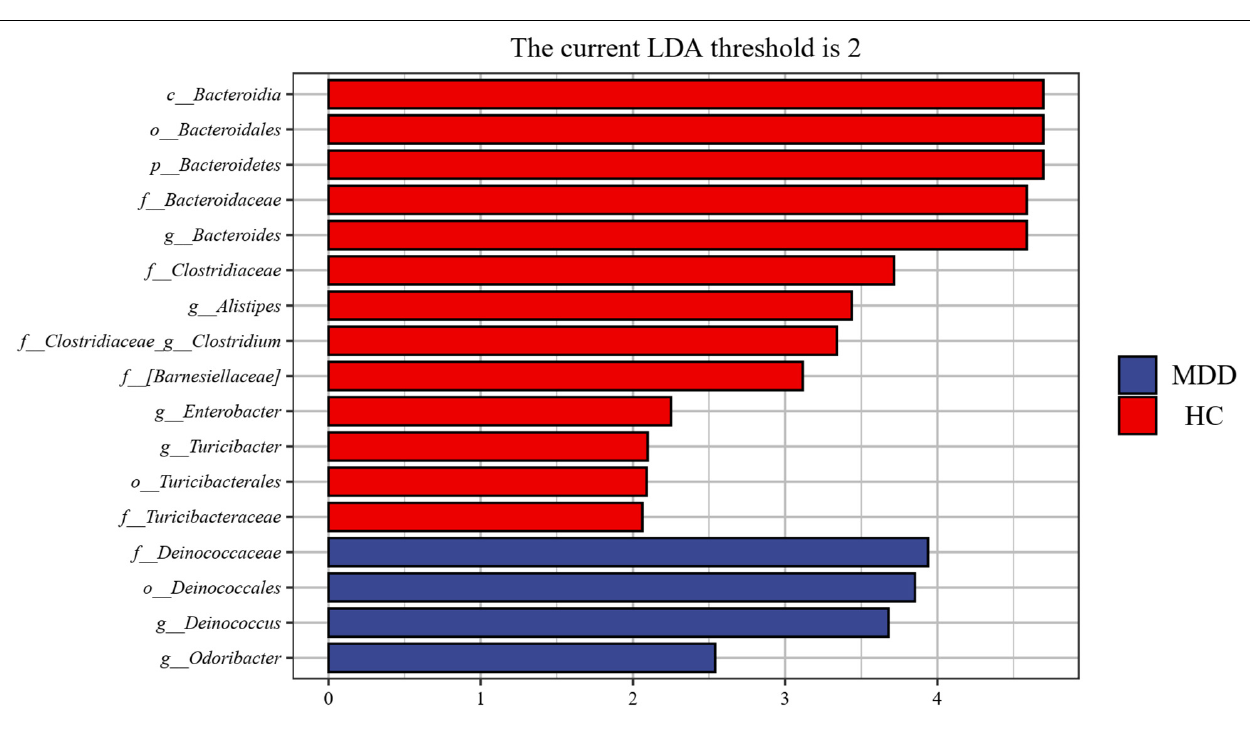
FIGURE 4 | Taxonomic biomarkers found by LEfSe in MDD and HC. Blue and red colors represent MDD and HC enriched family or genus, respectively. Only taxa with p < 0.05 and LDA score (log2) are